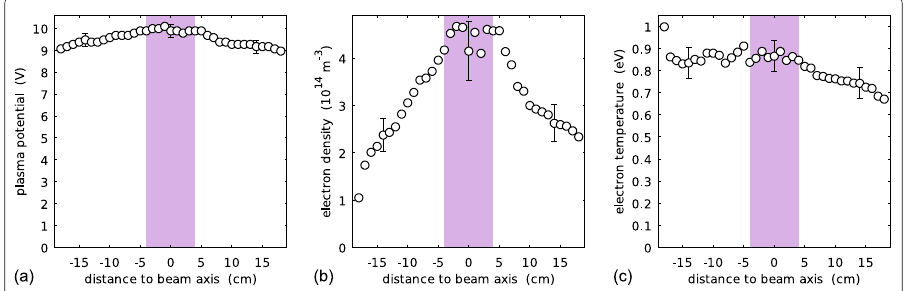
Fig. 6 Beam profiles in the HIBEX test chamber in Kiel measured with a movable cylindrical Langmuir probe. The shaded regions indicate the core of the beam, i.e. the diameter to which the beam is restricted by the aperture in the screen. (a) Plasma potential, (b) electron density, (c) electron temperature. (The positions < 0 and > 0 in the plots correspond to the upper and lower half in Fig.